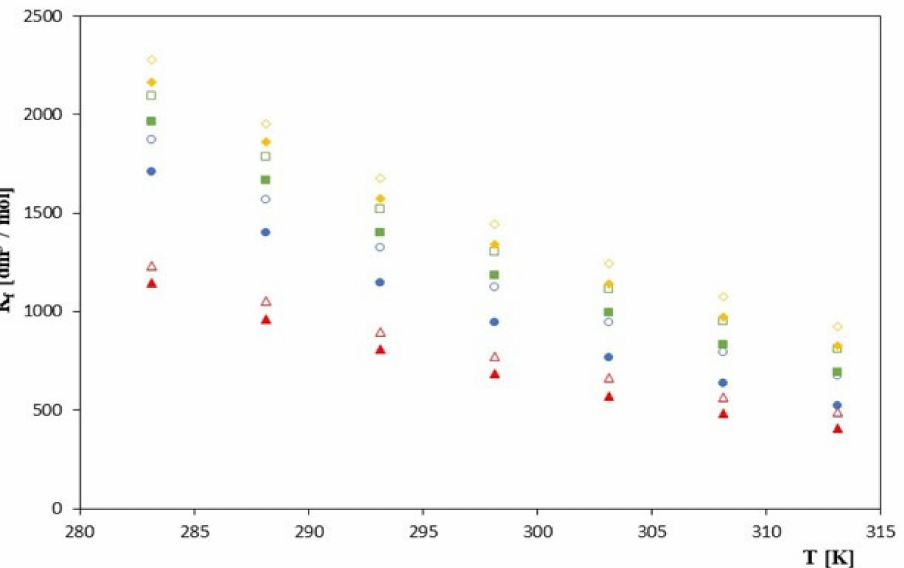
Figure 1. The plots of dependence of the K f [dm 3 /mol] formation constant in the T [K] function for β -cyclodextrin with all studied salts.: - trans -cinnamic acid; - trans –p-coumaric acid; - trans -caffeic acid; - trans -ferulic acid and 2-HP- β -cyclodextrin with the studied salts.: - trans -cinnamic acid; - trans –p-coumaric acid; - trans -caffeic acid; - trans -ferulic